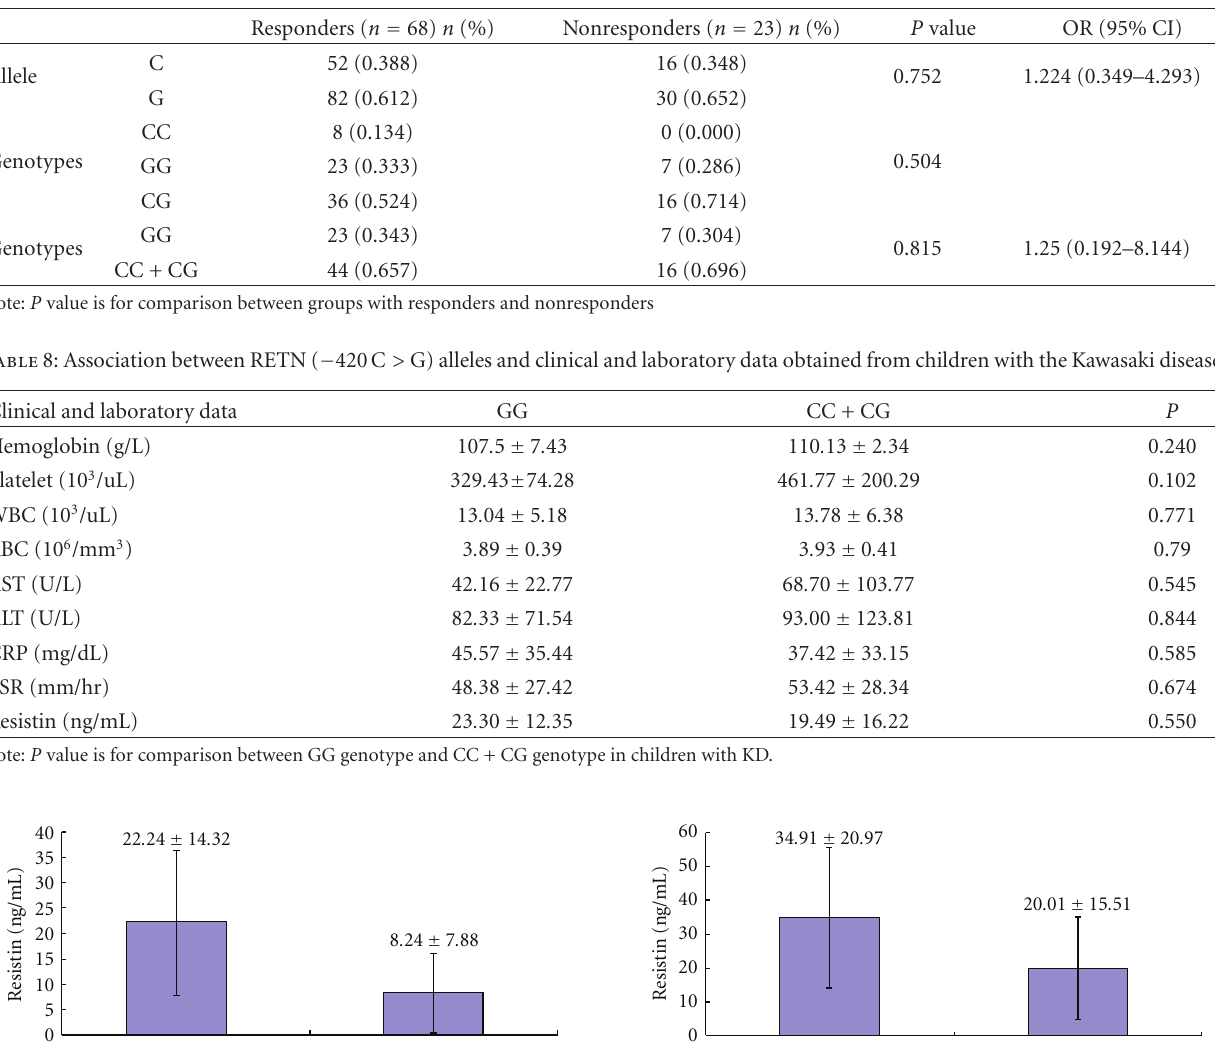
Table 7: RETN ( − 420C > G) genotype and allele frequency in the groups with responders and nonresponders.